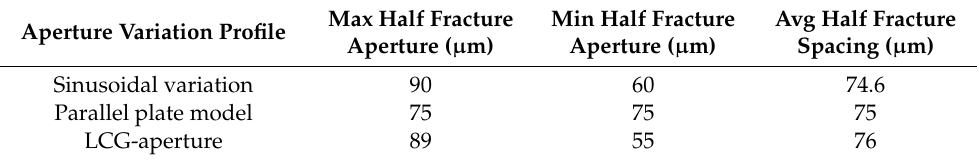
Table 1. Maximum, minimum, and average half fracture spacing values for different types of